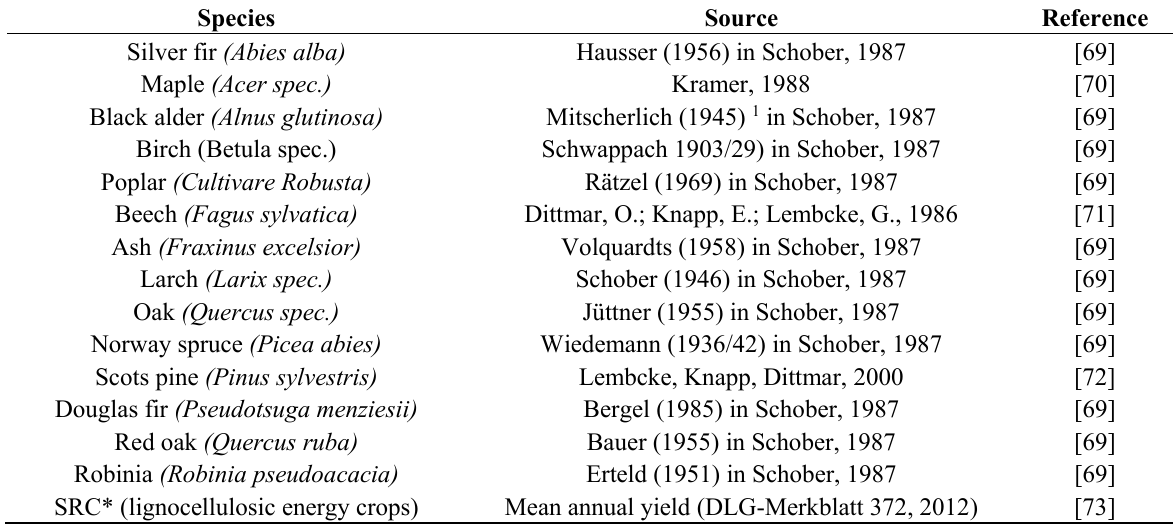
Table A3. Regional yield tables, which were used for the setup of the biomass module. *SRC = Short Rotation